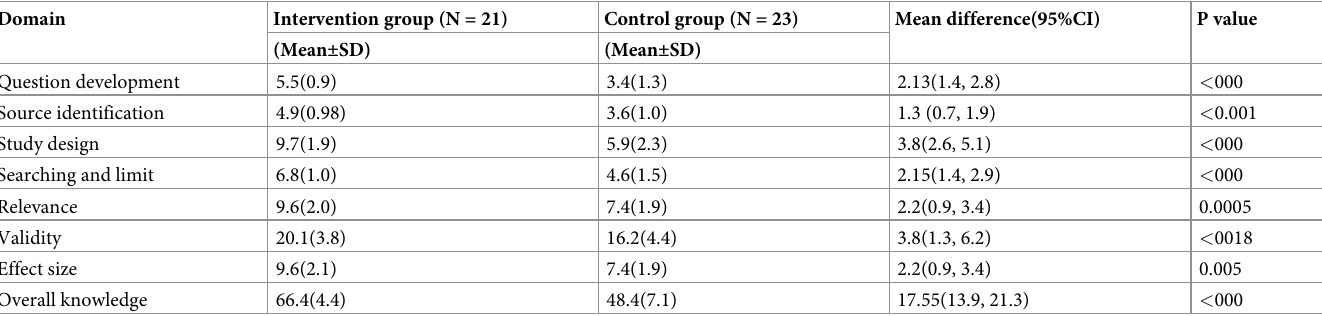
Table 2. Change of knowledge after training in postgraduate specialty students in Ethiopia,